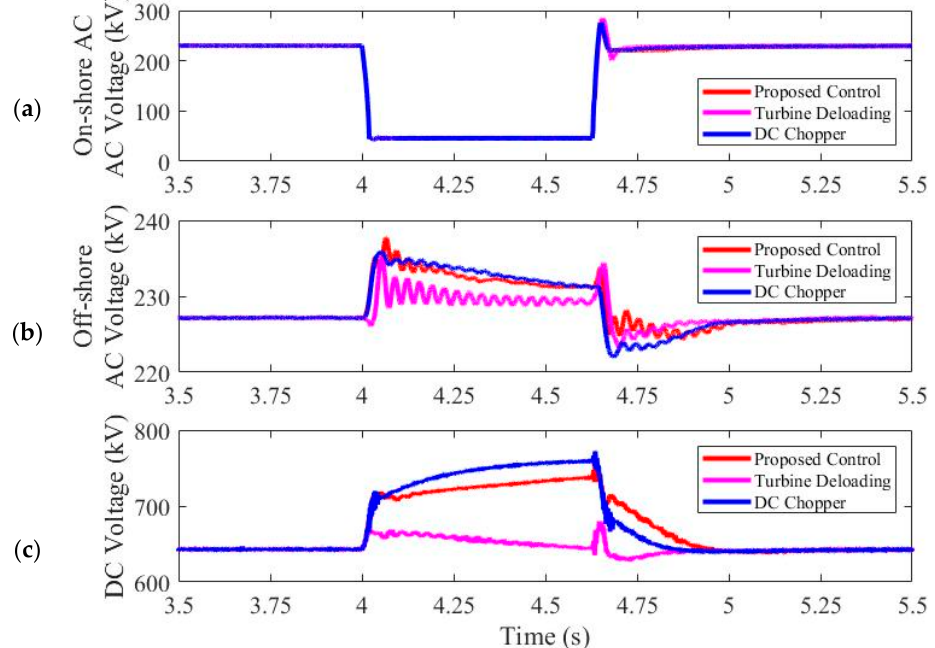
Figure 13. Simulation results of the on-shore fault scenario with a 2.95 Ω fault resistance. ( a ) On-shore AC voltage for each simulation case. ( b ) Off-shore AC voltage for each simulation case. ( c ) Rectifier-side DC voltage for each simulation case.